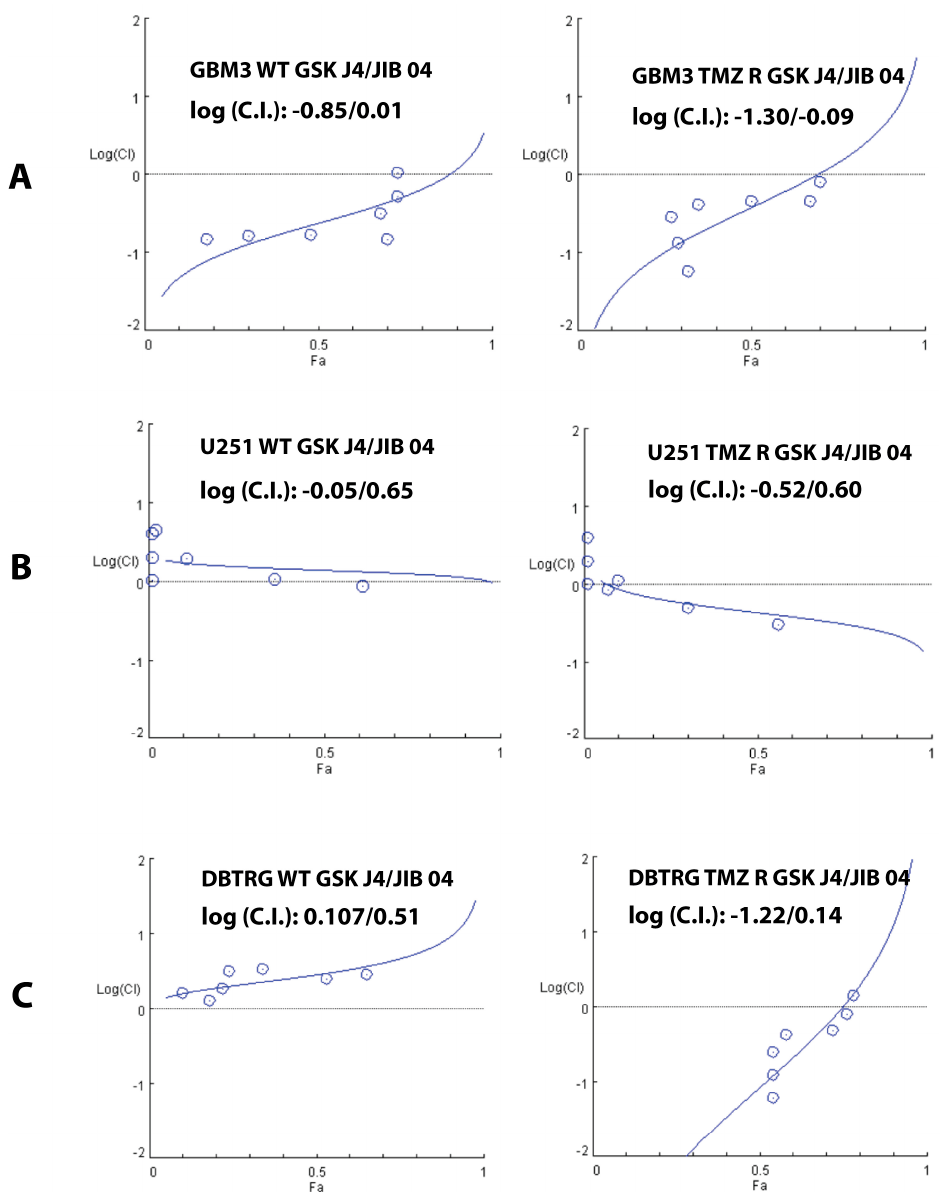
Figure 6. Synergy between GSK J4 and JIB 04 in GBM3, U251, and DBTRG native and TMZ resistant cells. The activity of the molecules was measured by MTS. The results are expressed as Plot of the log(C.I.) index vs. the effect (Fa), where log(C.I.) ≅ 0 indicates an additive effect, whereas log(C.I.): > 0 or < 0 indicates antagonism or synergy, respectively. ( A ) Combination experiments where GSK J4 and JIB 04 were added simultaneously and the cells were grown for 48 h. Both combinations were strongly synergic for native and TMZ-resistant cells, but this combination was more active against TMZ-resistant cells compared to native cells (log(C.I.): − 0.85/0.01 for WT and − 1.30/ − 0.09 for TMZ R cells). ( B ) Combination experiments conducted as in (A) with U251 cells. On WT cells, this combination was largely additive or antagonist at most concentrations (log(C.I.): − 0.05/0.65). On the contrary, the effect on TMZ R cells was synergic at several concentrations (log(C.I.): − 0.52/0.60). ( C ) Combination experiments conducted as in (A) with DBTRG cells. In this case, the combination was antagonist in WT cells (log(C.I.): 0.107 / 0.51) and strongly synergic in the TMZ-resistant derivative (log(C.I.): − 1.22 /